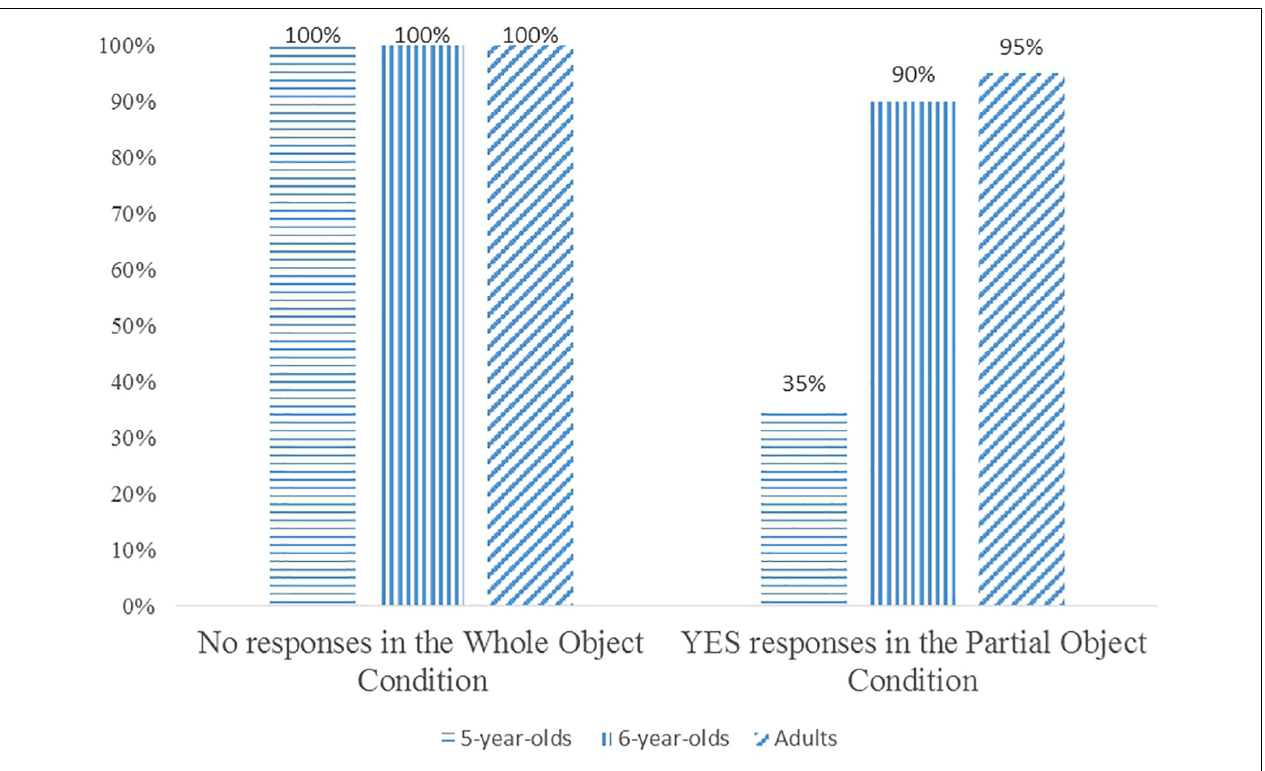
FIGURE 9 | Children’s and adults’ responses in the Whole Object Condition and the Partial Object